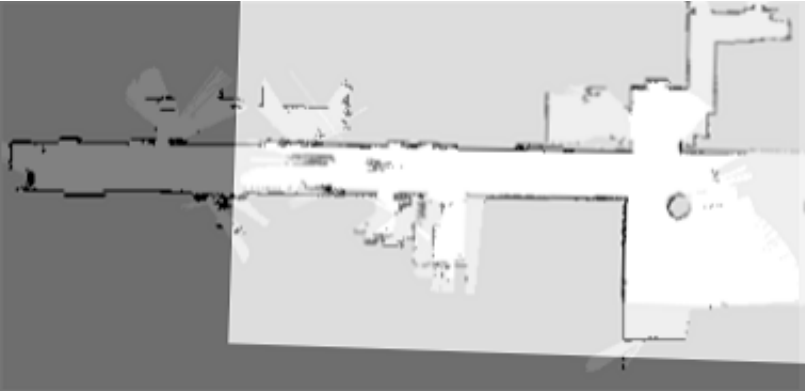
( a ) 𝐒 𝐌 : the sinogram of 𝐌 (cid:2871) ( b ) 𝐒 𝐌 (cid:3119) Figure 10. The sinograms, 𝐒 𝐌 and 𝐒 𝐌 , of the individual maps produced by three robots in indoor (cid:3119) (cid:3120) environments.